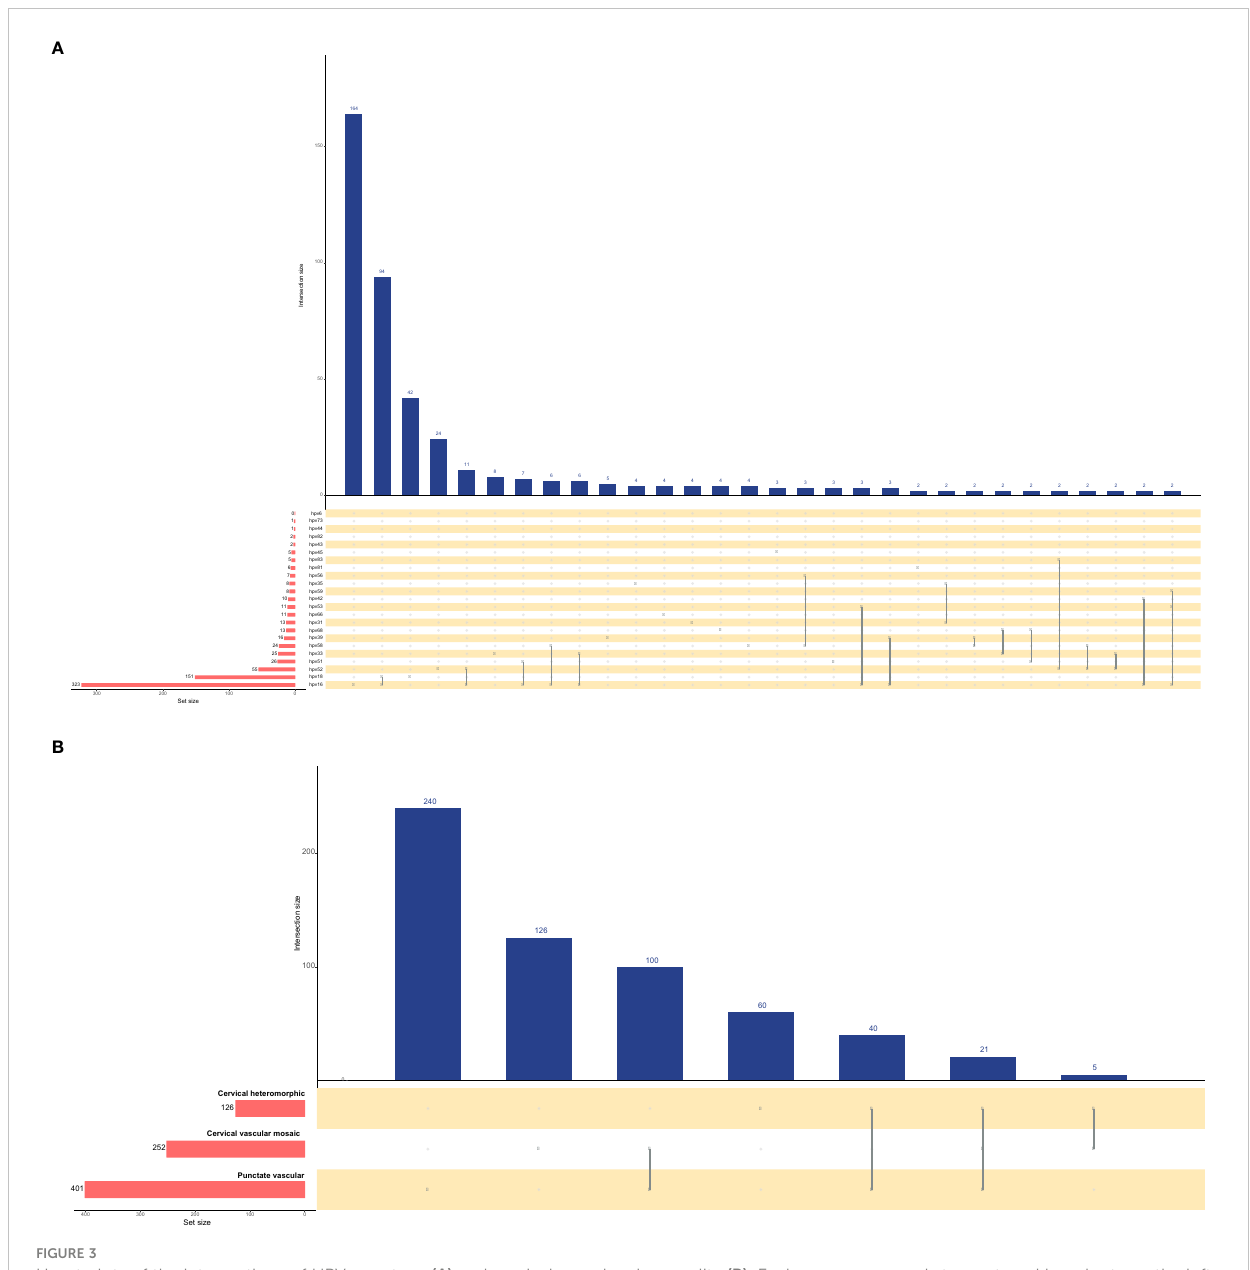
FIGURE 3 Upset plots of the intersections of HPV genotype (A) and cervical vascular abnormality (B) . Each row corresponds to a set, and bar charts on the left show the size of the set. Each column corresponds to a possible intersection: the fi lled-in cells show which set is part of an